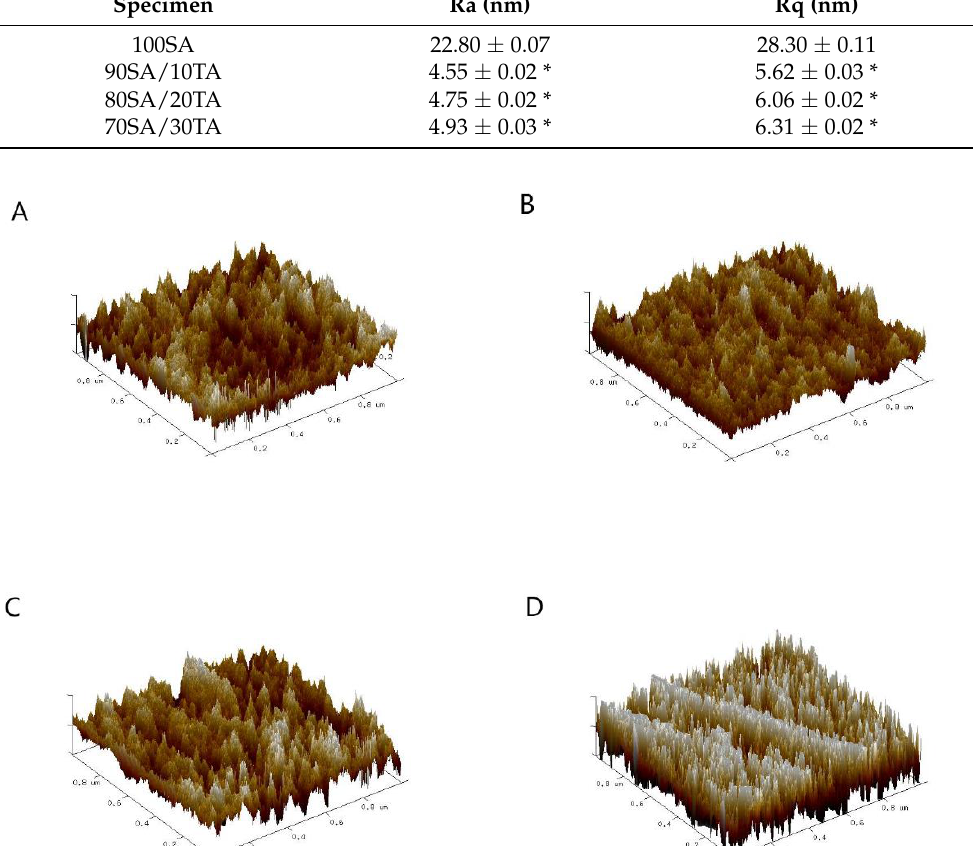
Figure 3. AFM three-dimensional images (1 µm × 1 µm) of ( A ) 100SA ( B ) 90SA/10TA ( C )80SA/20TA ( D ) 70SA/30TA (the presented images are representative for five specimens). Table 1. Roughness parameters (Ra and Rq) of sodium alginate/tannic acid films (n = 5; * signifi- cantly different from 100SA — p < 0.05) .